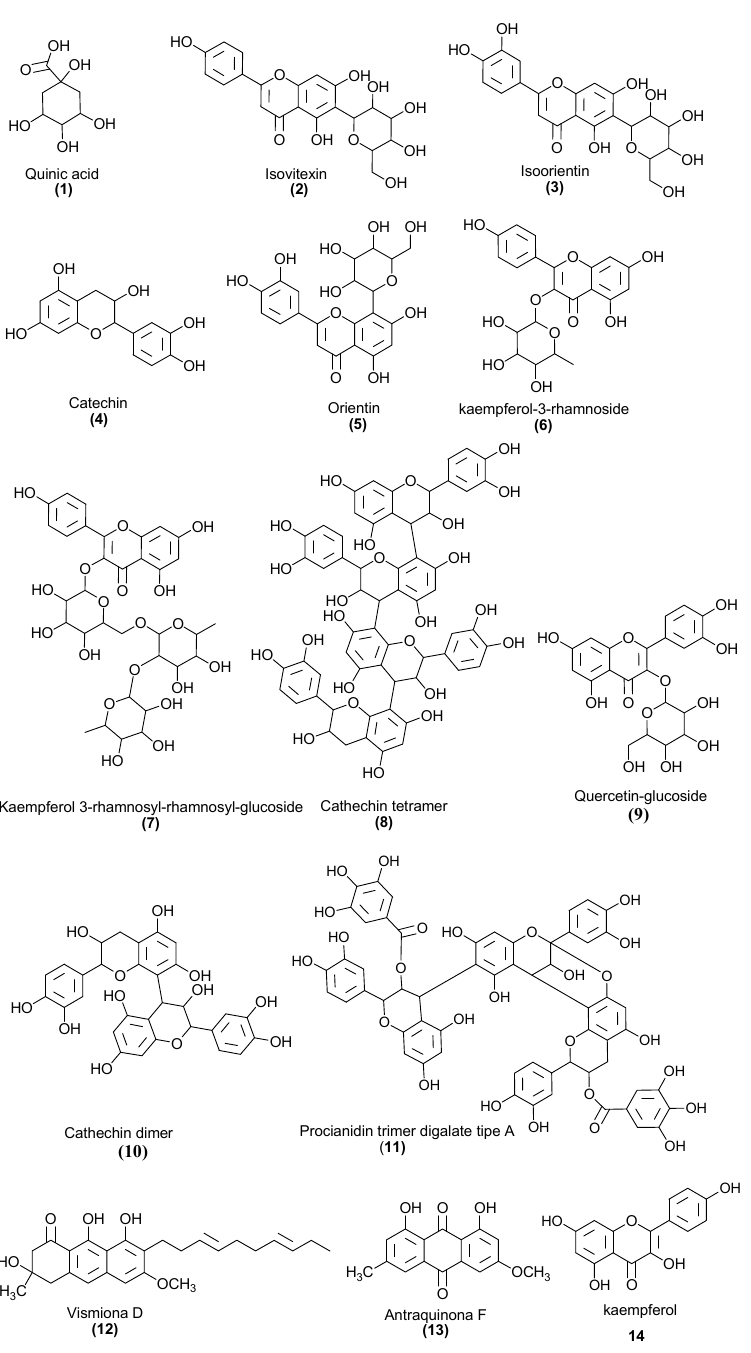
To define the best concentrations of the extract of Vismia guianensis (EHVG) for the antifungal assays, its hemolytic and cytotoxic activities were evaluated. The extract showed low toxicity, inducing less than 10% cell death and hemolysis (Figure 5A,B) at concen- trations ≤ 5 mg/mL. Cell viability was greater than 80% at concentrations ≤ 10 mg/mL (Supplementary Materials: Figure